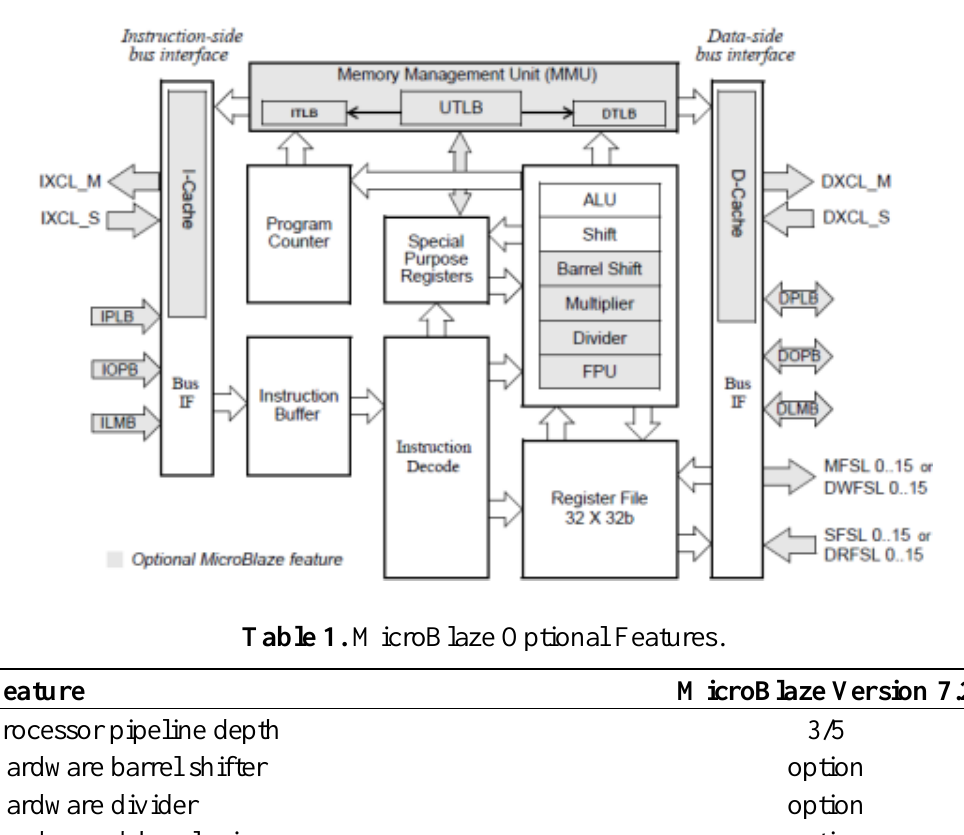
Figure 5. MicroBlaze Core Block Diagram [29].